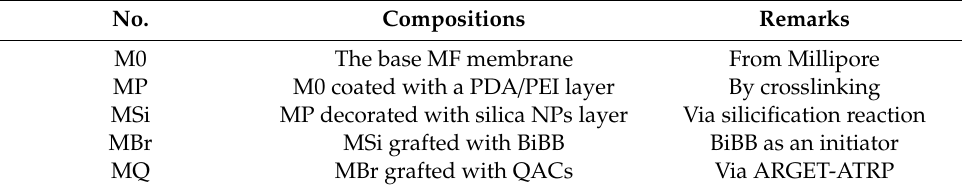
Table 1. Relative information of all the